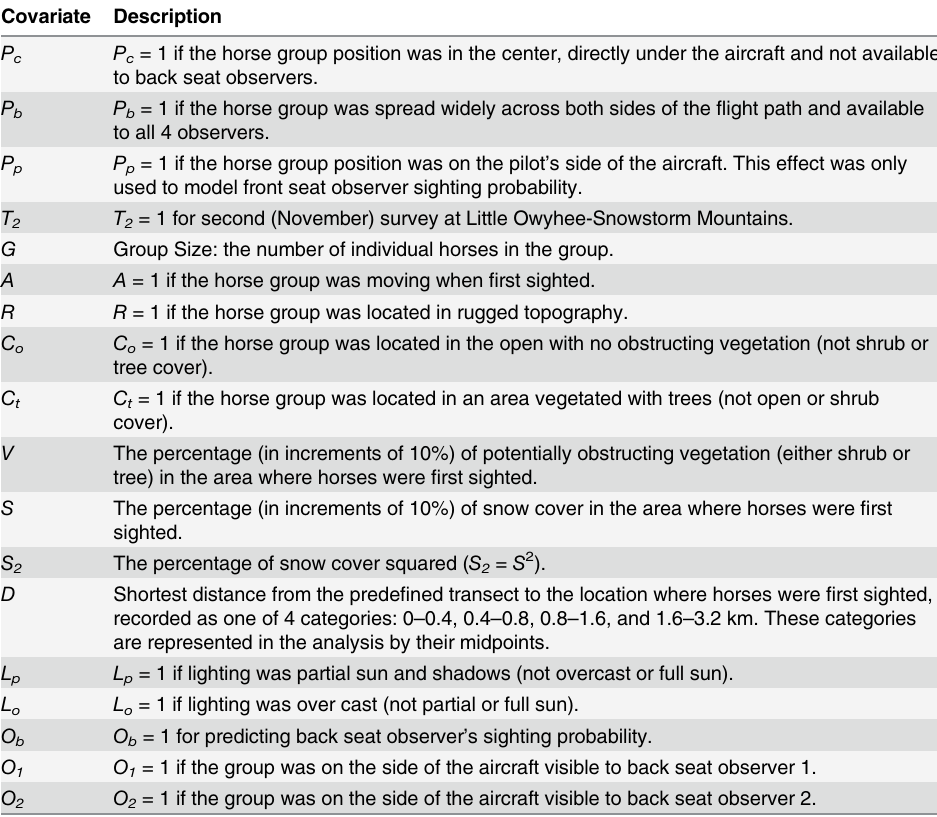
Table 1. Definitions of covariates considered in sighting probability models for feral horses ( Equus caballus ) in western USA. Covariate